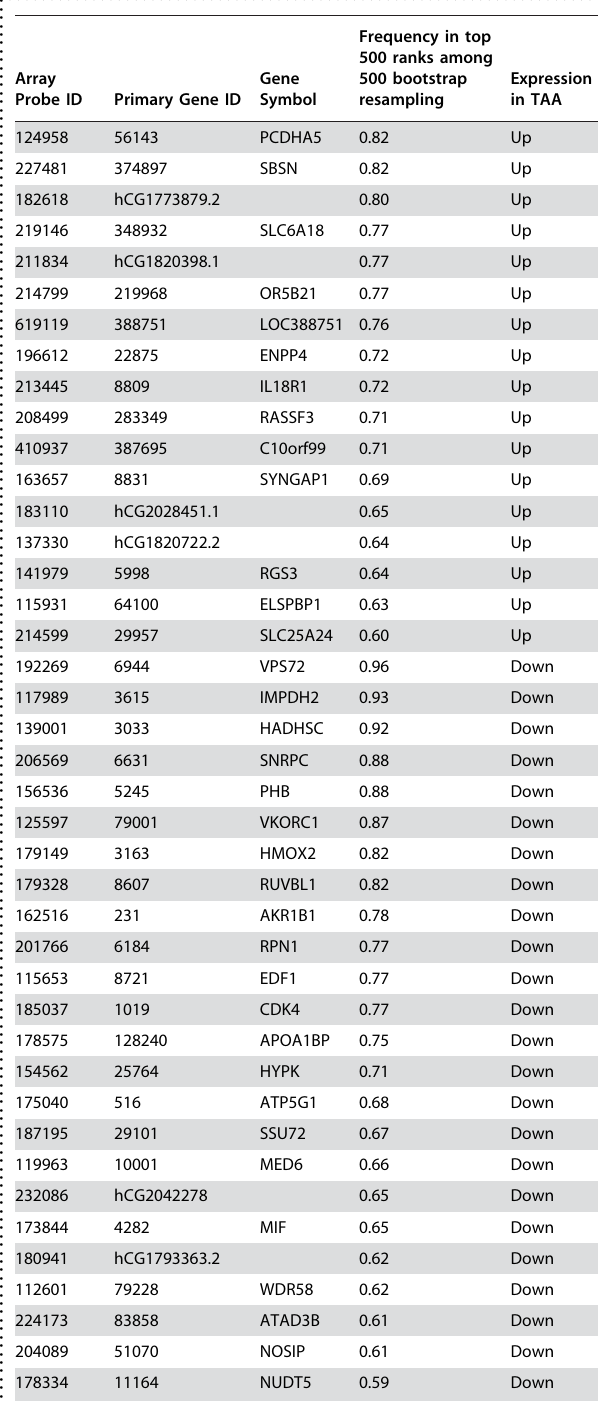
Table 2. List of the 41 classifier genes that distinguish TAA